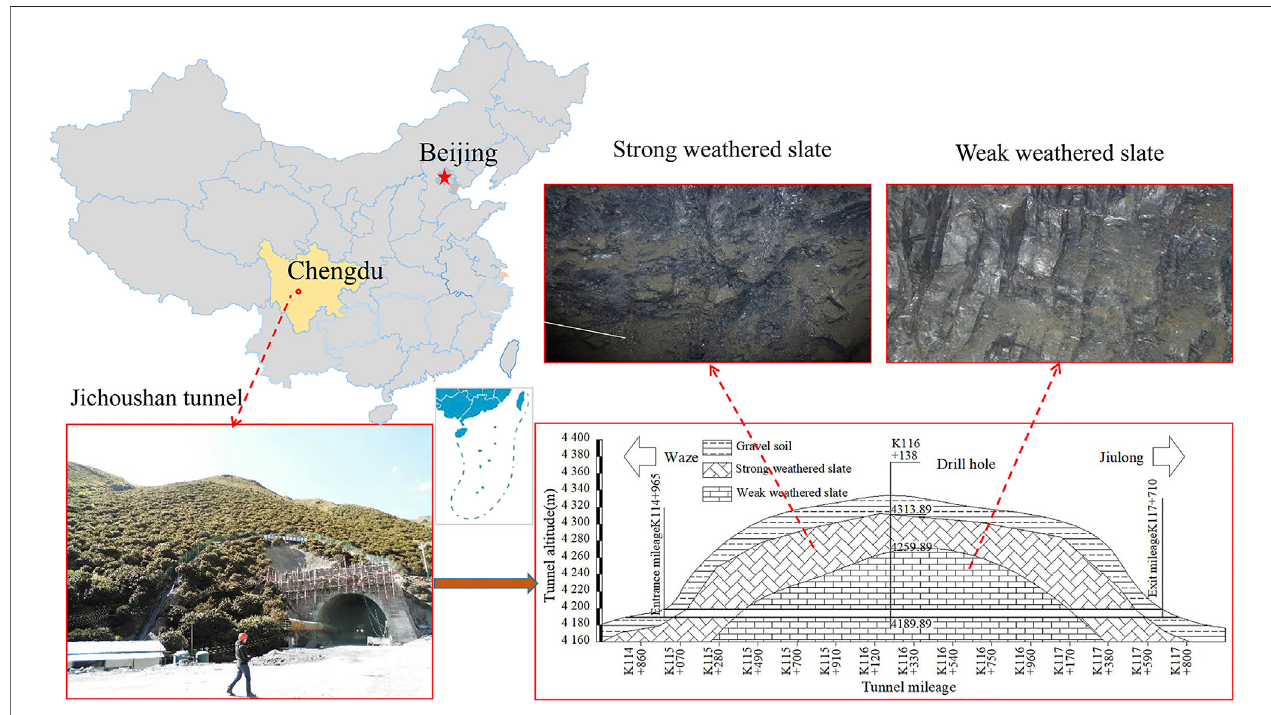
FIGURE 1 | Jichoushan tunnel pro fi